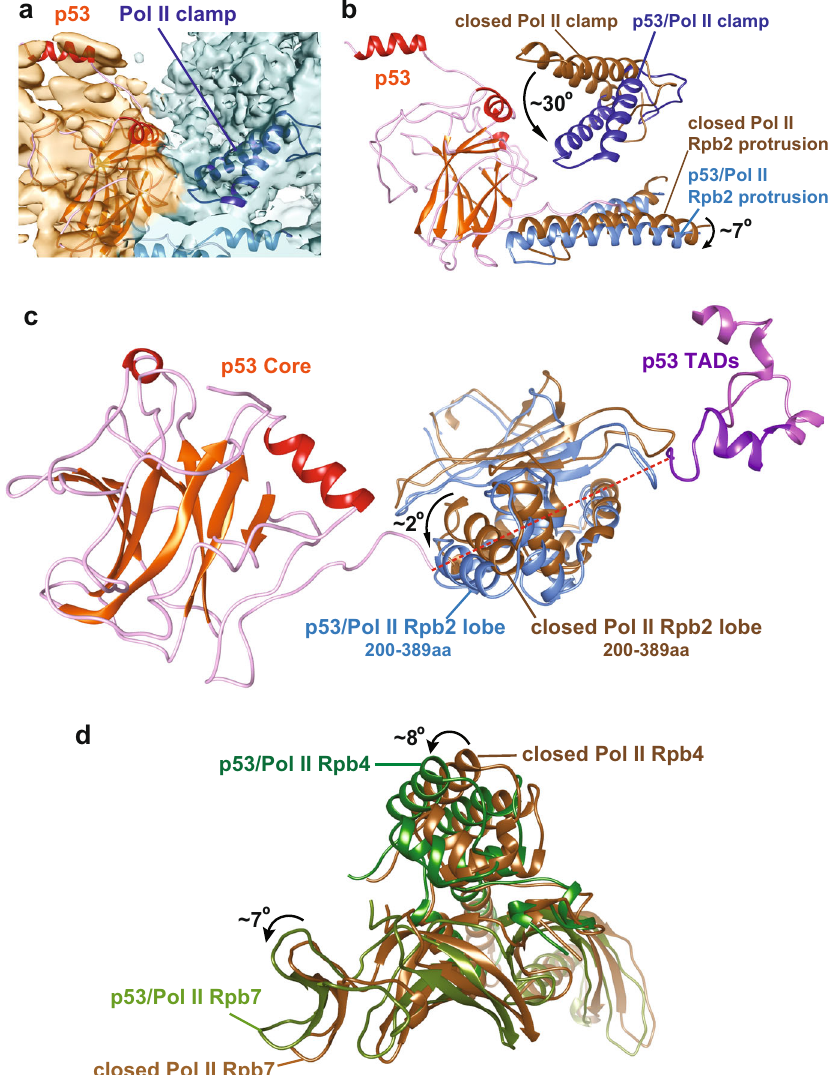
Fig. 4 Conformational changes of Pol II upon p53 binding. a Multi-body re fi nement of the p53/Pol II 3D reconstruction was performed to improve the cryo-EM density covering the Pol II clamp coiled-coil region (Pol II in teal color and p53 in orange color). Pol II clamp displaying a signature feature of the coiled-coil (dark blue) is indicated. b Upon p53 core domain binding, conformational changes of Pol II clamp coiled-coil and Rpb2 protrusion within Pol II are observed via comparing both molecular structures of closed Pol II (PDB: RCSB 5IYA 6 , brown) and p53-bound Pol II (dark blue). p53 binding introduces movement of Pol II clamp coiled-coil, approximately ~30° downwards into a further-closed state, along with ~7° downward movement of Rpb2 protrusion (sky blue). c The Rpb2 lobe of p53-bound Pol II (sky blue) moves ~2° downwards compared to the closed Pol II (PDB: RCSB 5IYA 6 , brown). This structural change of the Rpb2 lobe would likely be induced by the proline-rich domain of p53 (indicated as green line and the red dash line). d p53-bound Pol II stalk (composed of Rpb4/7, green) is in comparison with the closed Pol II stalk (PDB: RCSB 5IYA 6 , brown). Distinct conformational change of the Pol II stalk upon p53 interaction is observed, since Rpb4 and Rpb7 within p53/Pol II move approximately 8° and 1Å, and 7° and 3 Å,